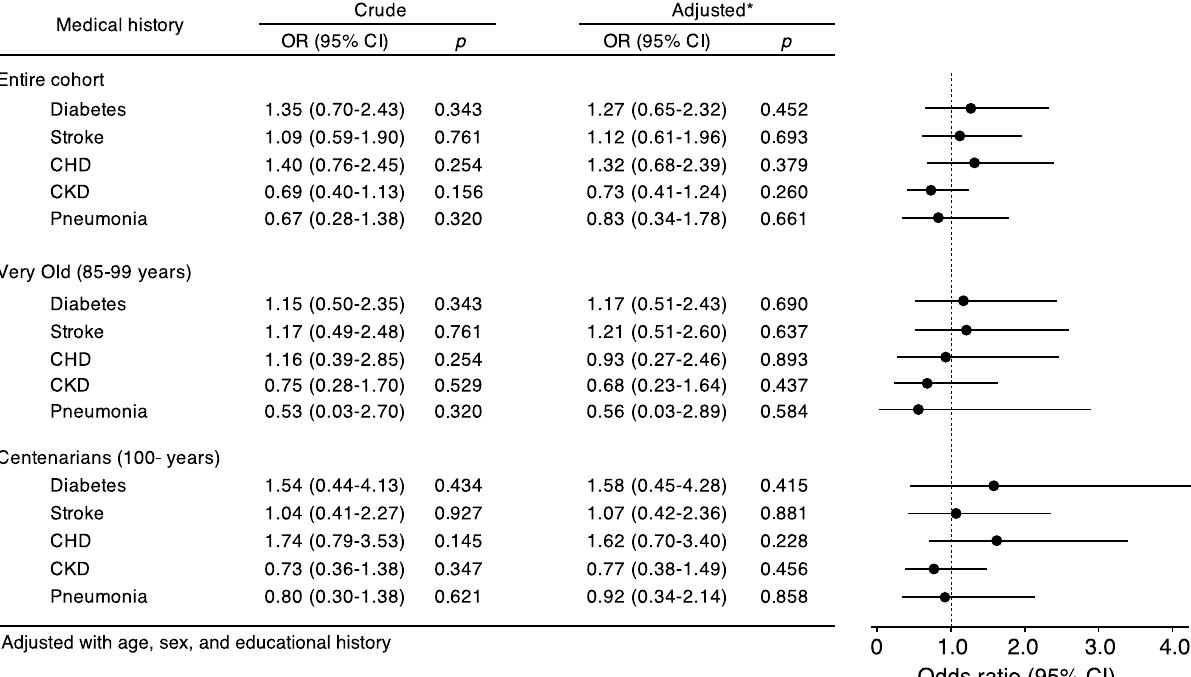
Figure 2. Odds ratios for medical history between the SOD3 p.R231G non-carriers and heterozygotes. Number of SOD3 p.R231G non-carriers and heterozygotes in Very Old was 453 and 48, respectively, and the number of SOD3 p.R231G non-carriers and heterozygotes in Centenarians was 549 and 44, respectively. The results in the “Crude” column indicate the results analyzed using the generalized linear model without adjustment factor, and the results in the “Adjusted” column indicate the results analyzed using a generalized linear model adjusted with age, sex, and educational history. The black circles and lines in the figure indicate the odds ratio (OR) and range for 95% confidence interval (CI) in the “Adjusted” results, respectively. These results suggest that approximately a tenfold concentration difference in plasma EC-SOD by SOD3 p.R231G genotypes was not associated with medical history, including DM, stroke, CHD, CKD, and pneumonia, in both the Very Old and WGS of 351 Centenarians was 1.08 million and the average read coverage depth was 40.5. The number of SNVs in which the minor allele frequency was more than 0.02 was 6,342,067. From the results of the quantitative trait association analysis using EC-SOD concentration in plasma and 6,342,067 SNVs, rs1799895 C > G SNV, which corresponds to the SOD3 p.R231G missense variant, was detected as the most significantly associated variant ( p = 2.18 × 10 −218 ). Although the other three variants were also detected as plasma EC-SOD concentration-associated variants, an enlarged view of the GWAS results indicated that these three variants were located around rs1799895 and would not be independent and weakly associated with rs1799895 (Fig. 1c). To confirm the relationship between the SOD3 p.R231G genotype and plasma EC-SOD concentration, we genotyped rs1799895 in all Very Old and Centenarians and compared the distribution of plasma EC-SOD concentration among SOD3 p.R231G genotypes (R/R ( SOD3 p.R231G variant non-carriers), R/G ( SOD3 p.R231G heterozygotes), and G/G ( SOD3 p.R231G homozygotes)) in the Very Old and Centenar- ians (Fig. 1d,e). From the results, the distribution of plasma EC-SOD concentration was significantly different depending on the SOD3 p.R231G genotype in both the Very Old and Centenarians, except for one centenar- ian individual. These results indicate that plasma EC-SOD concentration could be determined based on the SOD3 p.R231G genotype and an approximately tenfold difference in plasma EC-SOD concentration was observed between the SOD3 p.R231G variant non-carriers and heterozygotes. SOD3 p.R231G genotype is not associated with medical history in the Very Old and Centenar- ians. To evaluate the effect of the SOD3 p.R231G genotype on comorbidity, we compared medical history including DM, stroke, coronary heart disease (CHD), CKD, and pneumonia among SOD3 p.R231G genotypes between the SOD3 p.R231G non-carriers and heterozygotes in the entire, Very Old, and Centenarians cohorts (Fig. 2). These results revealed that the medical history was mostly similar between the SOD3 p.R231G non- carriers and heterozygotes in the entire, Very Old, and Centenarians, suggesting that the approximately tenfold difference in the plasma EC-SOD concentration among the SOD3 p.R231G genotypes was not affected by medi- cal history including DM, stroke, coronary heart CHD, CKD, and pneumonia in the Very Old and Centenarians. Association between plasma EC-SOD concentration and age by SOD3 p.R231G genotype. As shown in Fig. 1d,e, the distribution range of plasma EC-SOD concentration in the SOD3 p.R231G variant non-